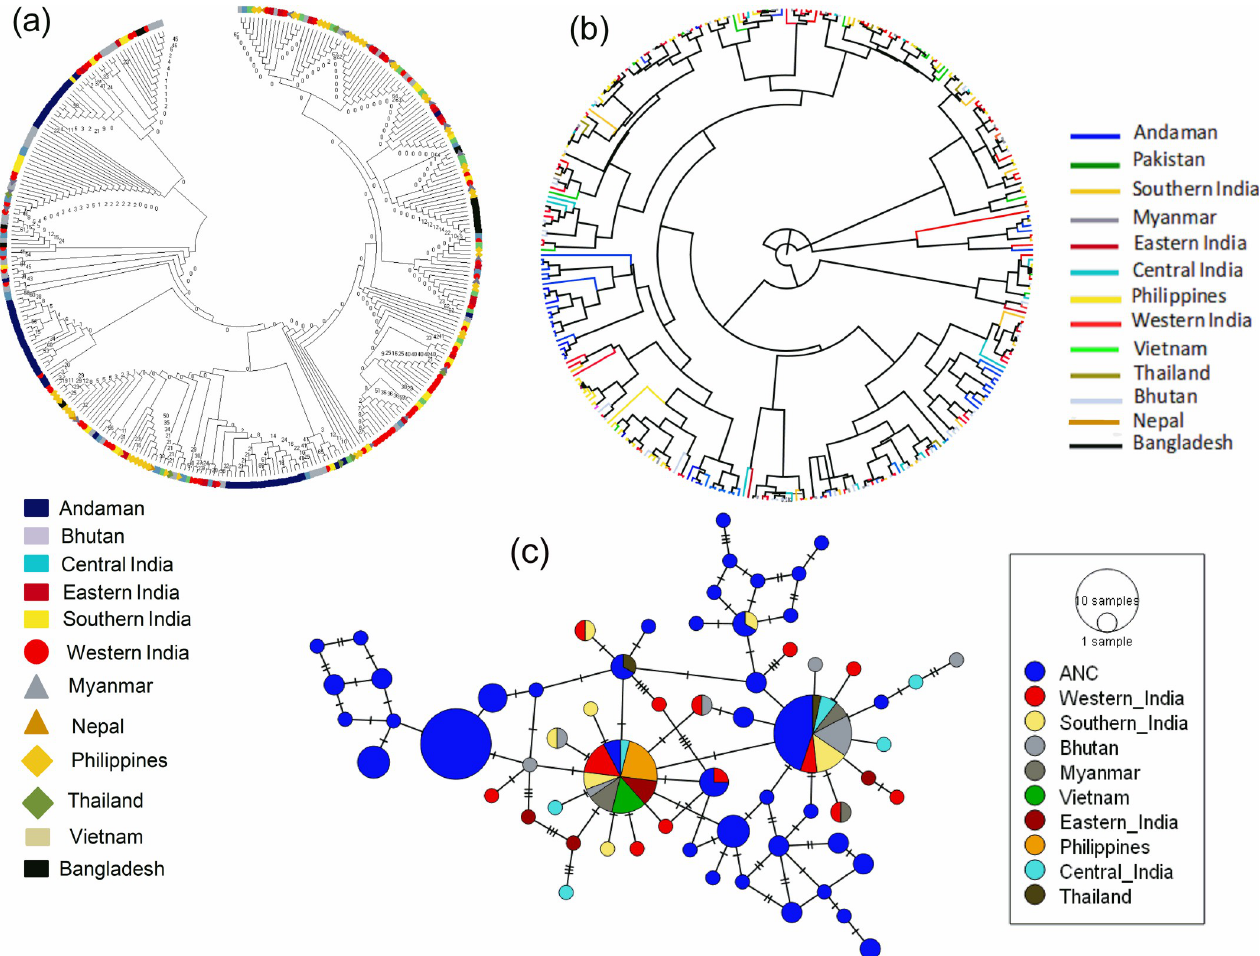
Fig 5. Haplotype I1 of ANC and its relationship with I1 cattle of Island Southeast Asian countries and Indian subcontinent. (a) Neighbor Joining (NJ) phylogenetic tree, (b) Bayesian phylogenetic tree, (c) A haplotype network map of the